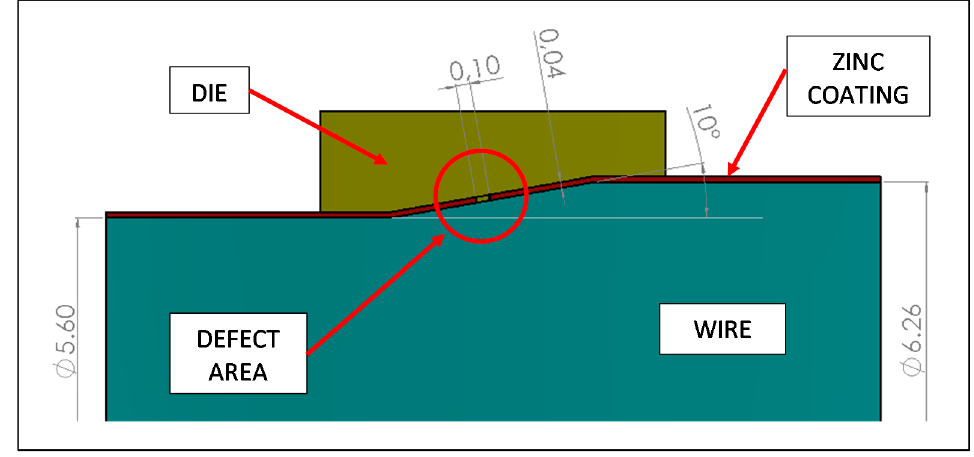
Figure 3. Model geometry for FEM analysis.